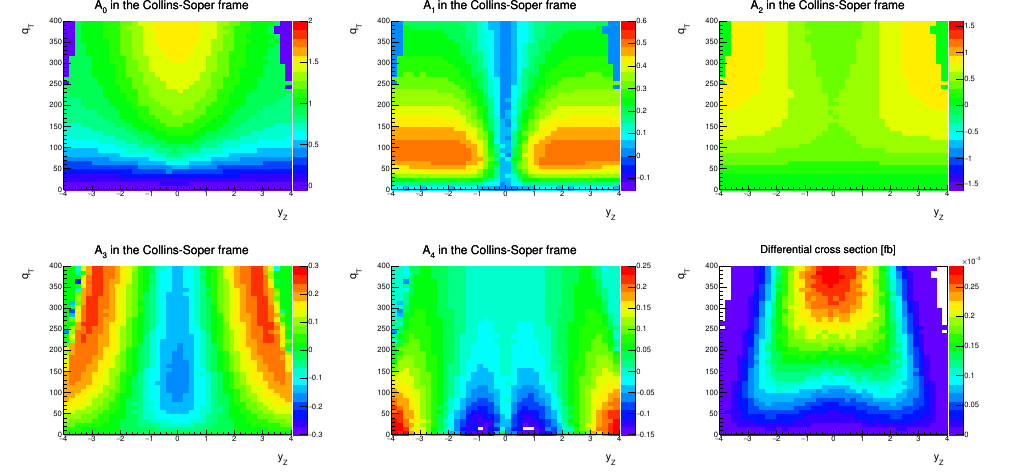
Figure 6 . Angular coe(cid:14)cients A 0 scenario S0 b .